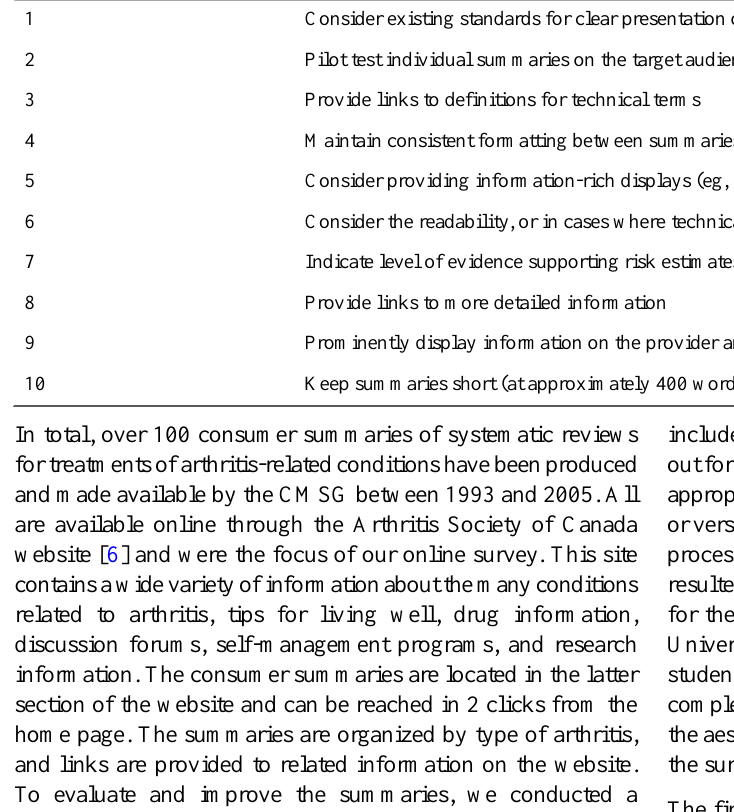
Table 1. Preliminary recommendations for presenting consumer summaries online